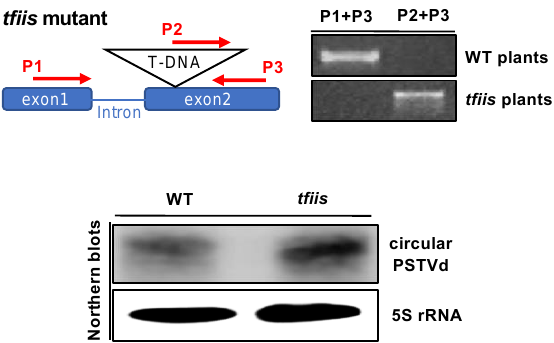
Figure 5. PSTVd replication in protoplasts. Top panel shows the schematic presentation of T-DNA disruption in the TFIIS locus and the genotyping result. The genotyping PCR, using two sets of primers (P1 + P3 and P2 + P3) confirmed wildtype plants and tfiis mutants. The bottom panel shows PSTVd replication in wildtype and tfiis protoplasts. The sequence of P2 primer is derived from the inserted T-DNA, while the P1 and P3 primers are derived from the endogenous gene. WT, wildtype.